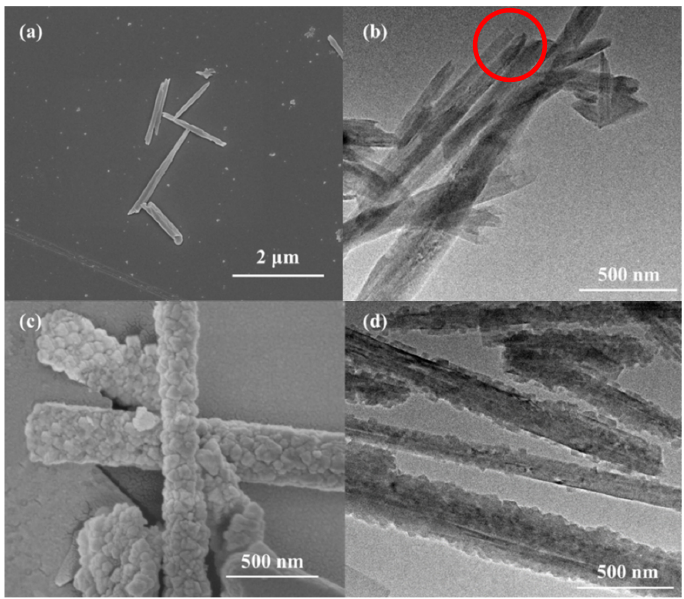
Figure 5. SEM image and TEM image of: ( a , b ) HNT and; ( c , d )